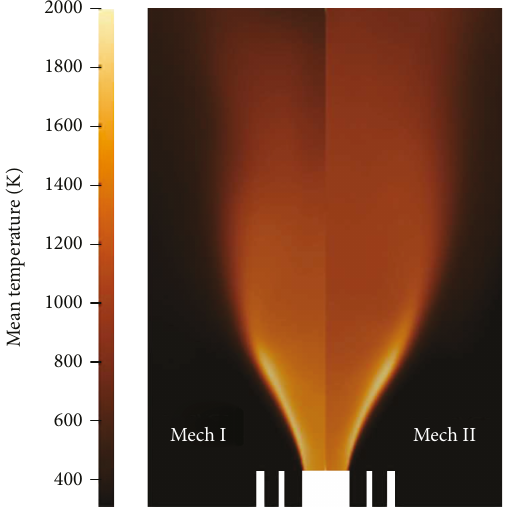
Figure 8: Comparison of simulated mean temperature distribution